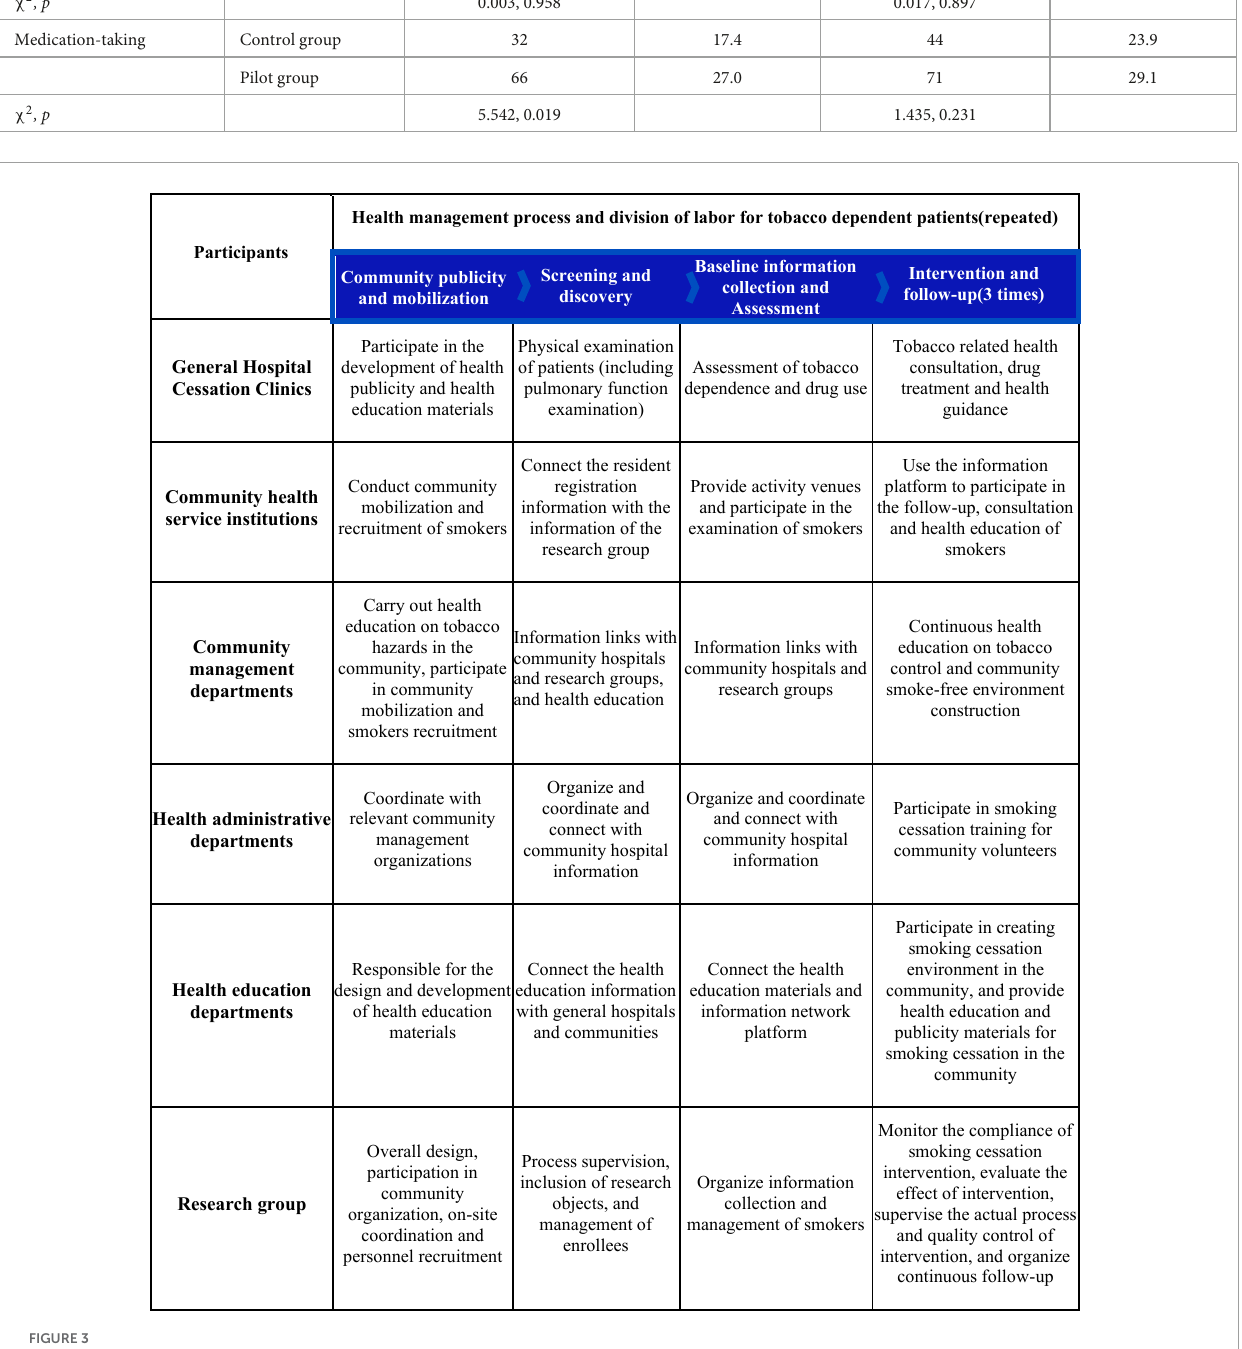
FIGURE3 Management pattern of tobacco dependence in hospital and community.